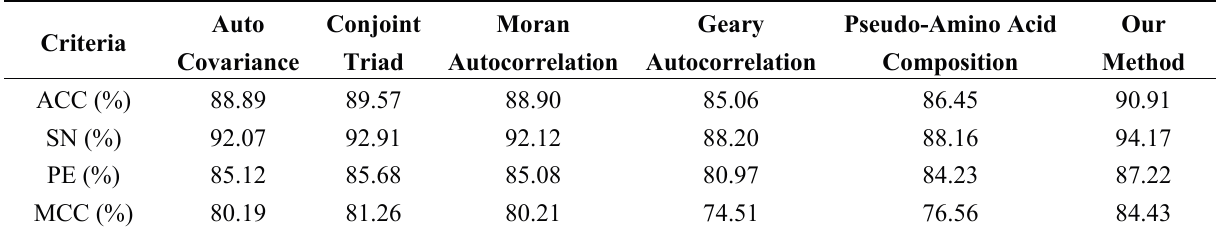
Table 5. Comparisons of different feature extraction